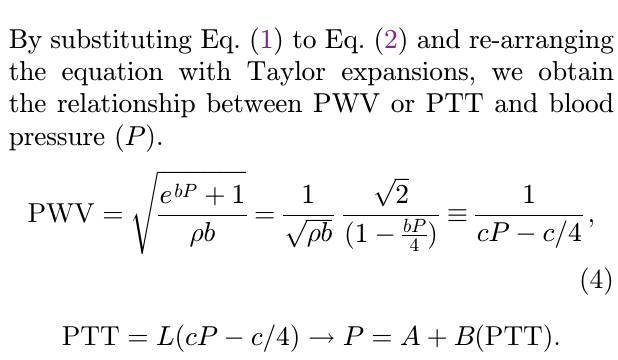
Fig. 1. The calibration process for detecting linear function by using three trials of